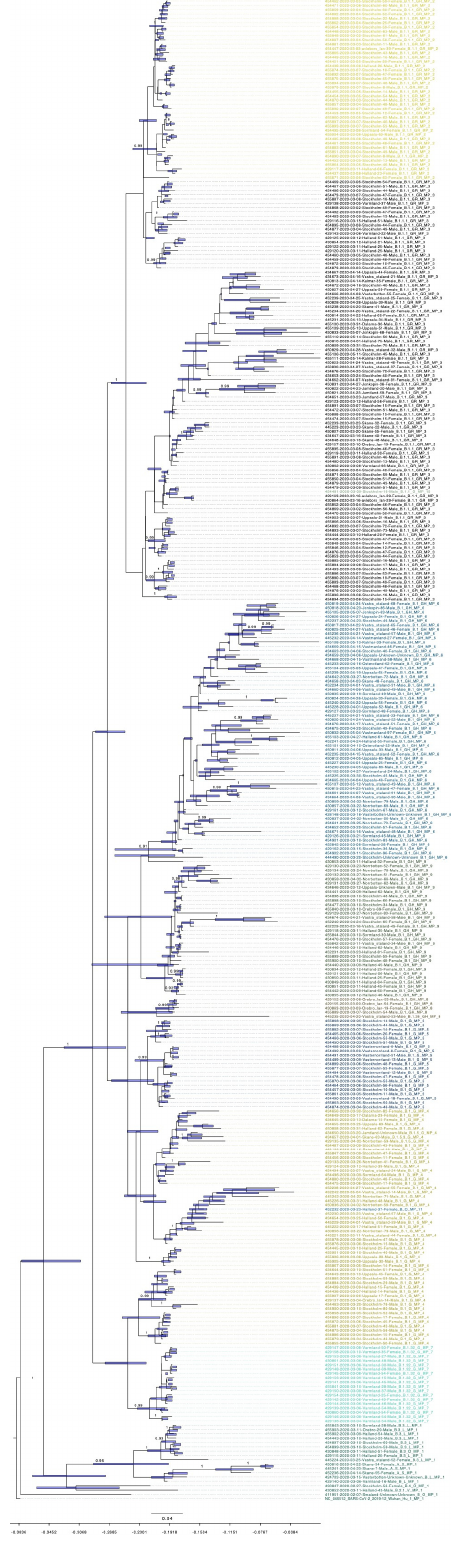
Figure 3. Dated phylogenetic tree of Swedish SARS-CoV-2. Posterior probability values are shown on the branches. The bar on the nodes show the confidence of the time with 95% highest posterior density (HPD). The time scale on the bottom indicates time before 14 May 2020, and tick values on the scale represent every 14 days. The color indicator is the same as in Figure 1.